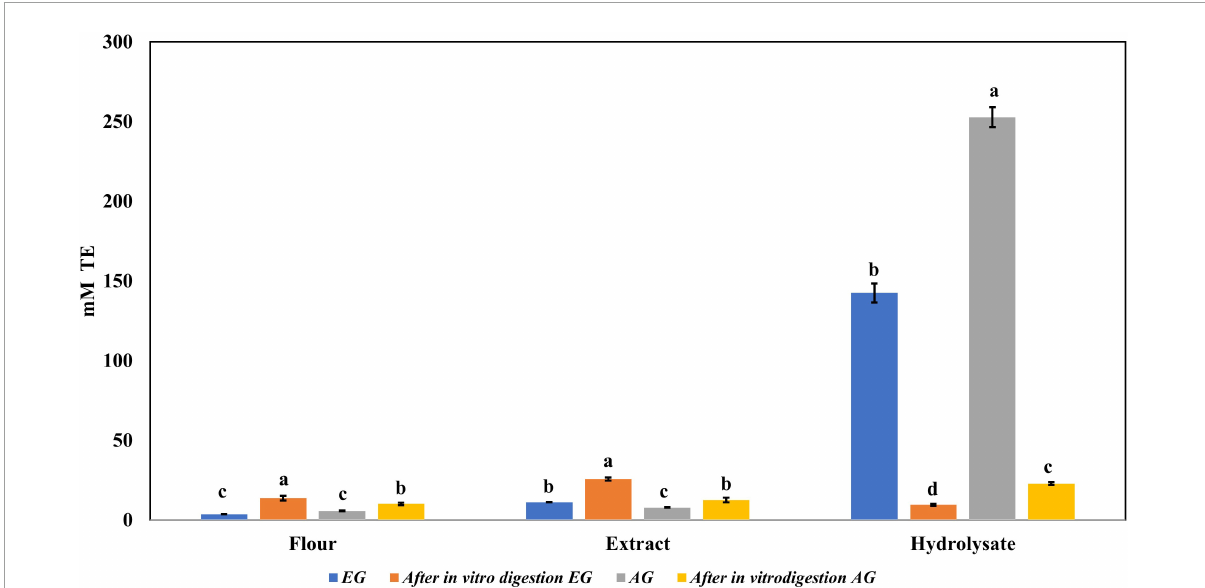
FIGURE7 Antioxidant activity against 2,2 (cid:48) -azino-bis(3-ethylbenzothiazoline-6-sulphonic acid) (ABTS) radical of flour, extracts, and hydrolysates of early grasshopper (EG) and adult grasshopper (AG) before and after in vitro protein digestion. Results obtained are reported in millimolar trolox equivalents (mM TE)/gram dry weight. Different letters between bars indicate significant difference ( p -value < 0.05).